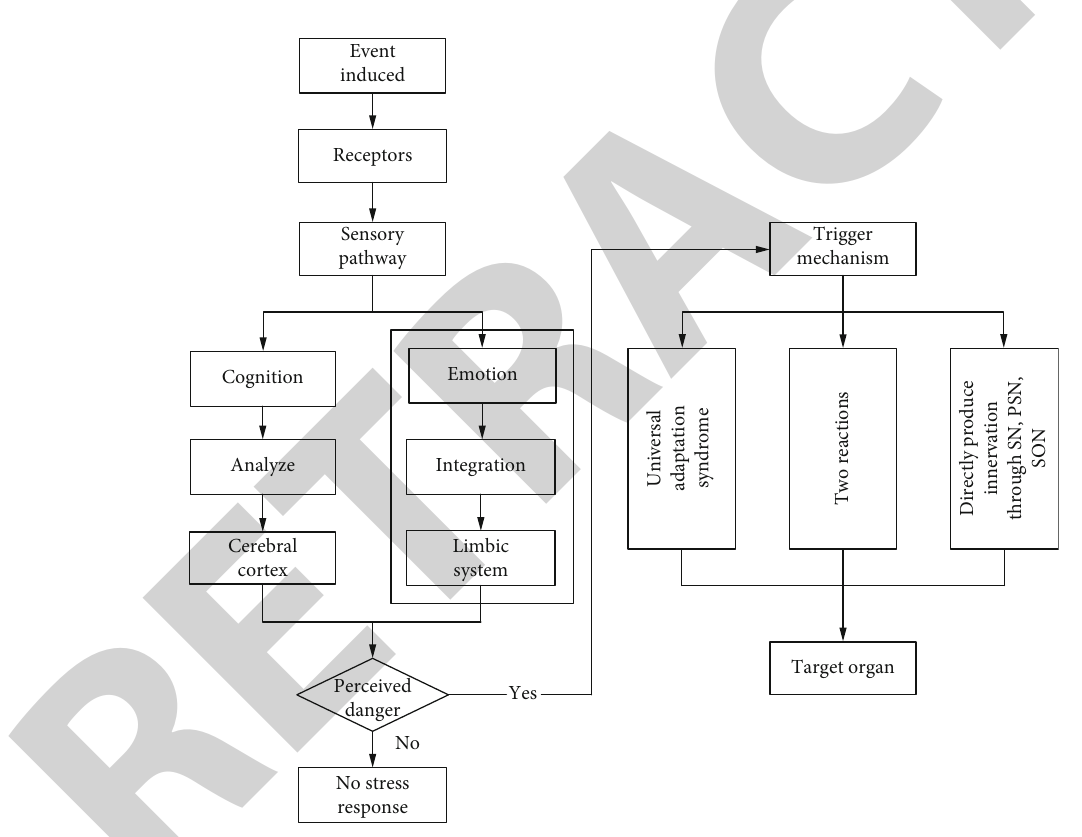
Figure 6: BP network structures.